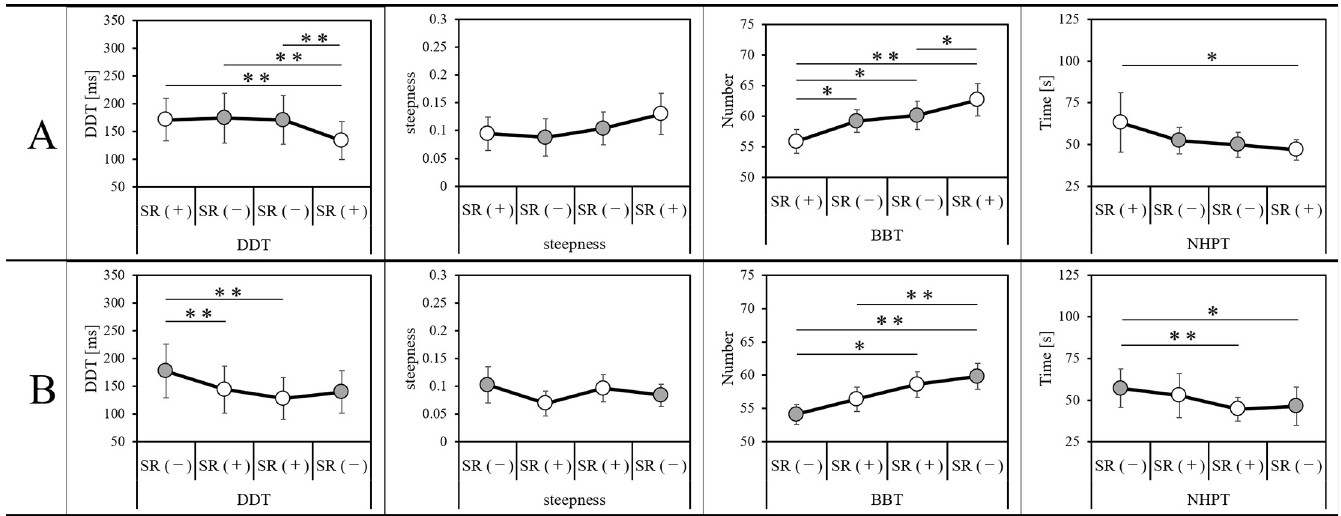
Fig 3. Time course of experimental data and comparisons. DDT, the delay detection threshold for the delayed visual feedback detection task; steepness, the steepness of the delay detection probability curve in the delayed visual feedback detection task; BBT, box and block test; NHPT, nine hole peg test; SR (+), stochastic resonance on- condition; SR (-), stochastic resonance off-condition. White circles, SR on-condition; gray circles, SR off-condition. �� P < 0.01; � P < 0.05; Bonferroni-corrected. (A) Time course of the experimental data of 15 participants (Group A; mean age ± standard deviation, 21.0 ± 0.8 years; range, 20–22 years; 8 male participants) who conducted the tasks in the order of SR on-condition, off-condition, off-condition, and on-condition. Error bars represent the standard error or the standard deviation of the mean. (B) Time course of the experimental data of another 15 participants (Group B; 21.0 ± 0.8 years; range, 20–22 years; 8 male participants) who conducted the tasks in the order of SR off-condition, on-condition, on-condition, and off-condition. Error bars represent the standard error or the standard deviation of the mean.